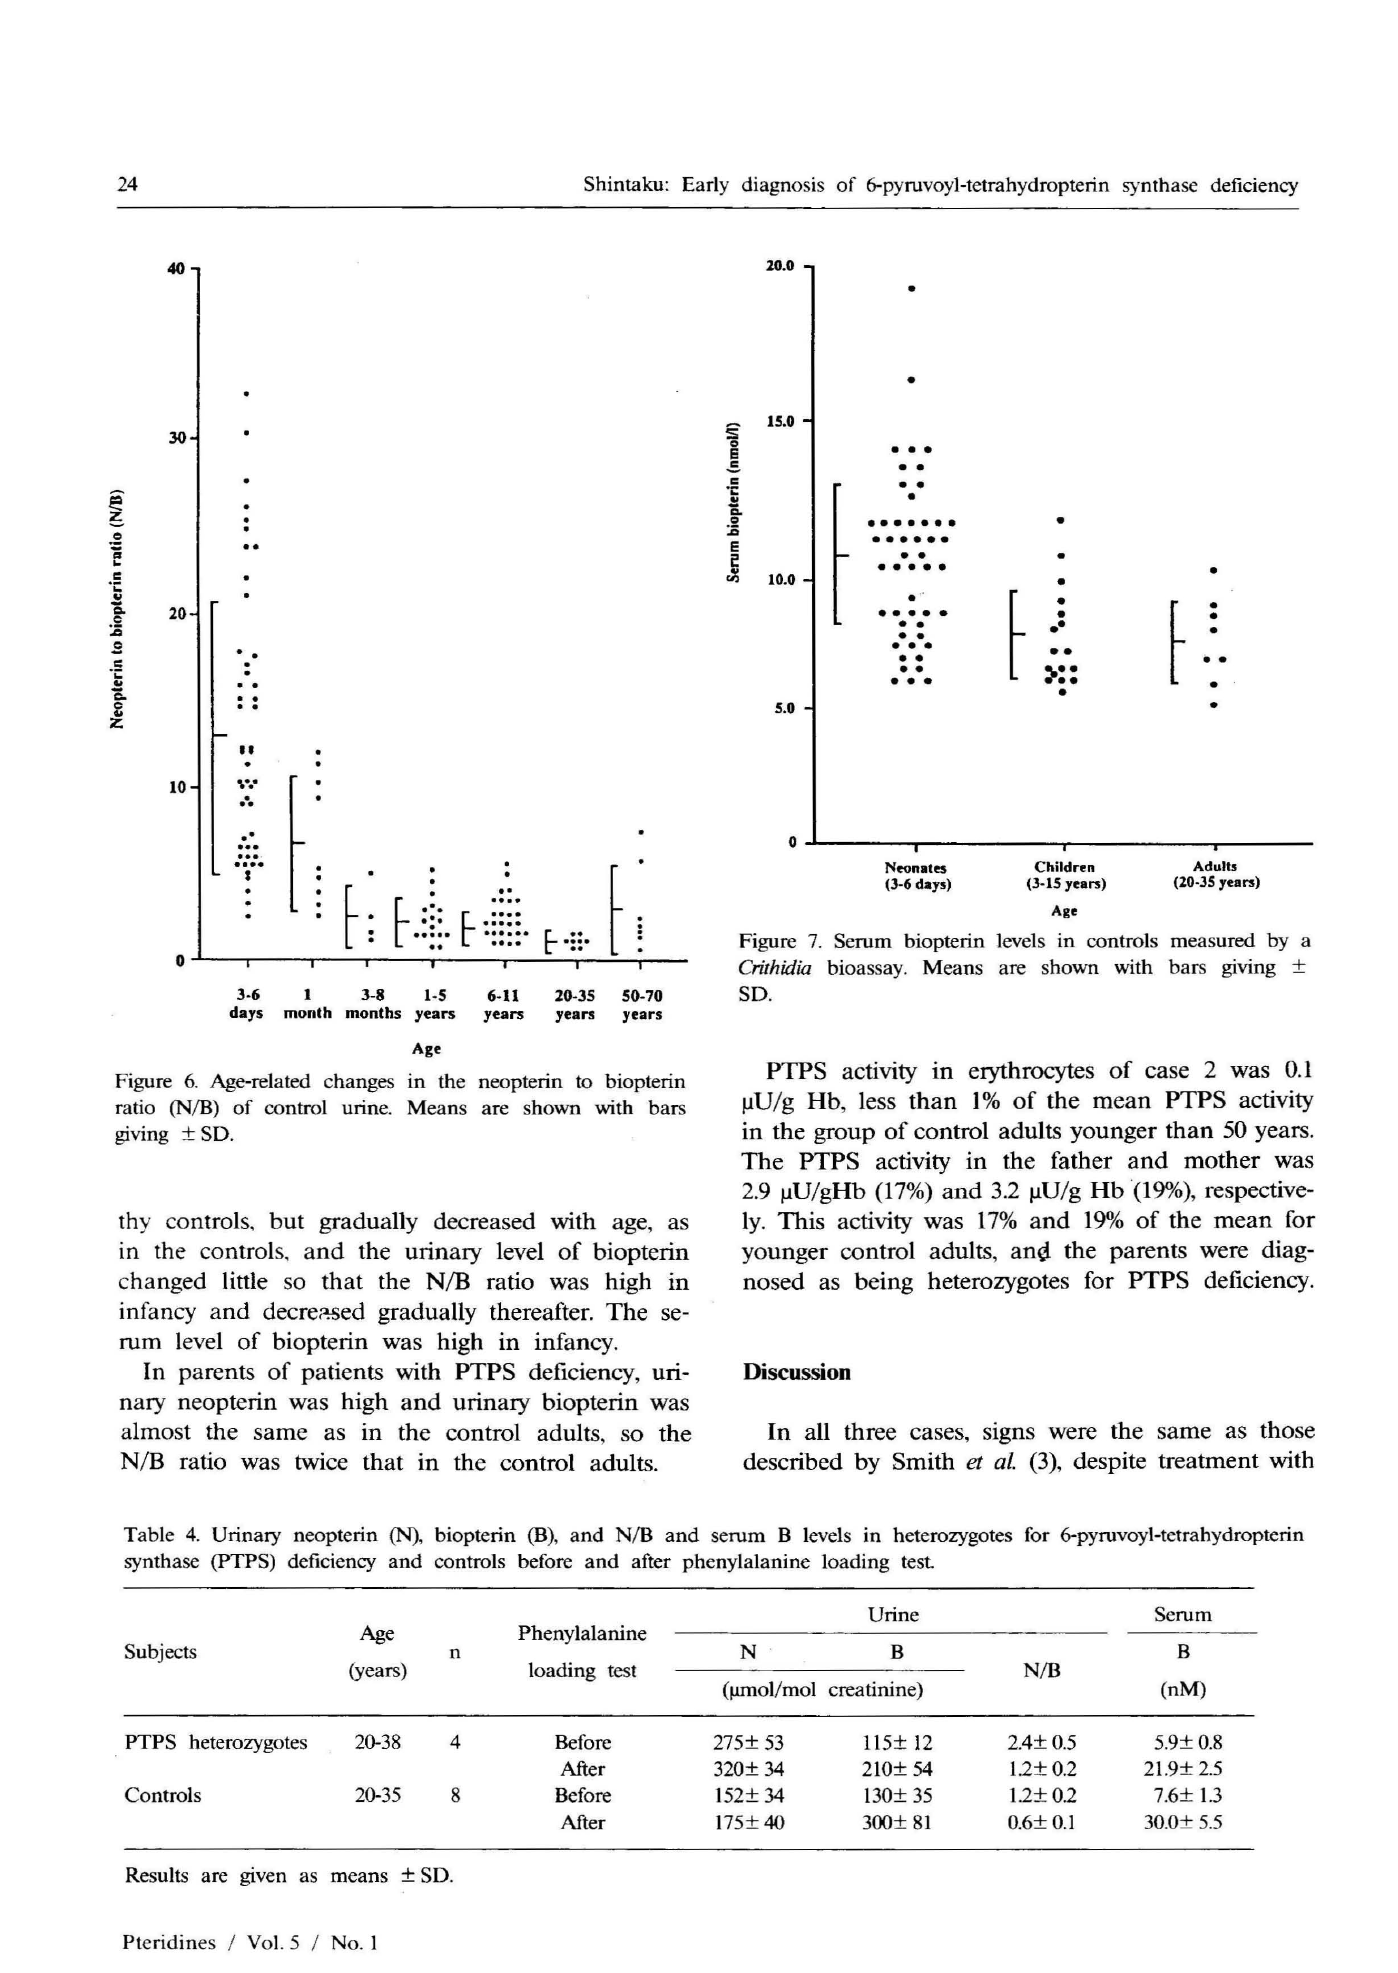
Results are given as means ± SD. Pteridines / Yol.5 /